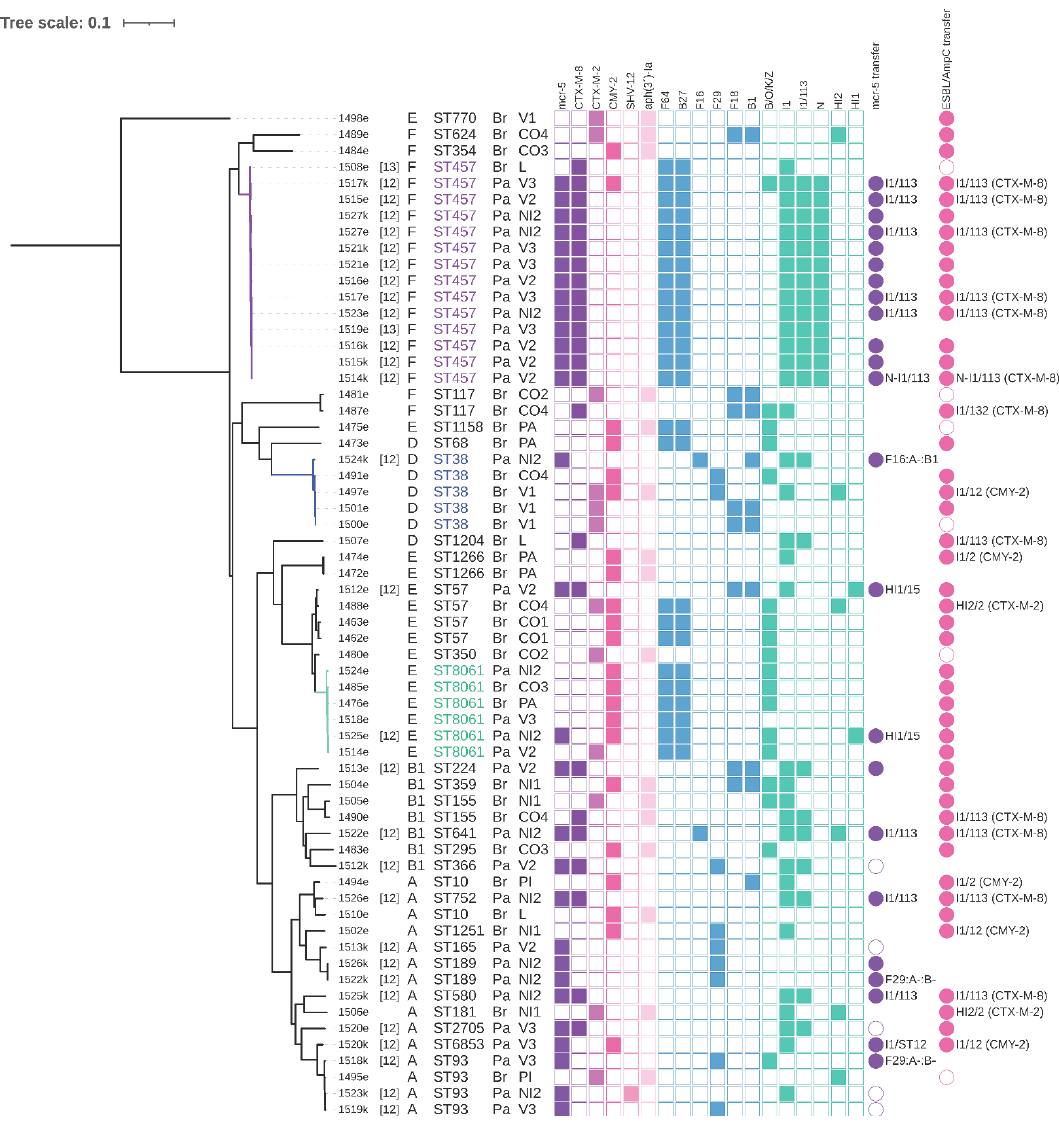
Figure 1. Phylogeny of Escherichia coli from Paraguayan farms. The most prevalent E. coli sequence types (STs) are highlighted in color. The columns represent isolate name (consist of the sample number and “k” for selection using colistin and “e” for selection using cefotaxime); reference number in case the isolate has been already part of previous publications; phylogenetic group; sequence type; hatchery (Br: Brazil, Pa: Paraguay) and farm (label consist of the village name and farm number: Villeta: V1–3; Nueva Italia: NI1-2; Colonel Oviedo: CO1–4; Paraguari: PA; Piribebuy: PI; Luque: L). The coloured squares indicate presence of selected antibiotic resistance genes (purple-pink), F plasmid replicons (blue) and other plasmids (turquoise). The colour circles indicate transferability of mcr-5.1 (purple) or extended-spectrum beta-lactamases (ESBL) and AmpC-type beta-lactamases (AmpC) encoding genes (pink) in conjugation experiments, a full circle means the conjugation was successful including confirmation of presence of respective genes by polymerase –chain reaction (PCR), empty circles represent unsuccessful conjugation experiments. For the single-plasmid fully-typed transconjugants, the information about which plasmid replicon carried the respective gene is presented next to the circle.